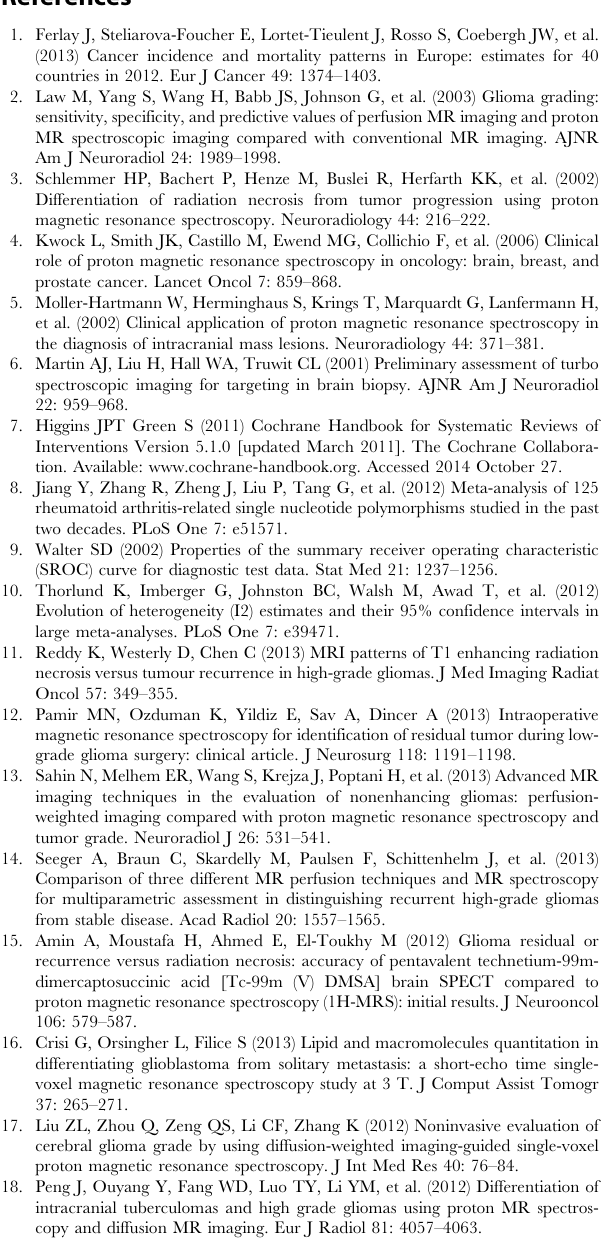
Figure S1 Risk of bias summary. Table S1 Detailed of risk of bias